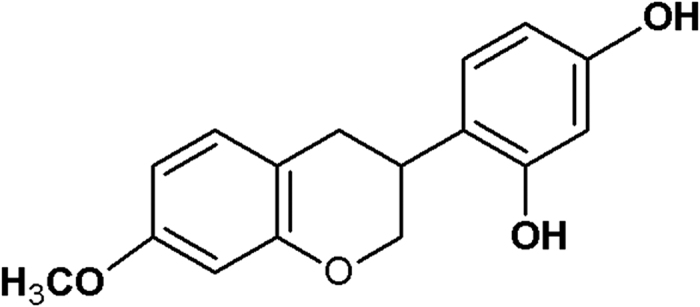
Chemical structure of neovestitol (C16H16O4; 272.29584 g/mol).